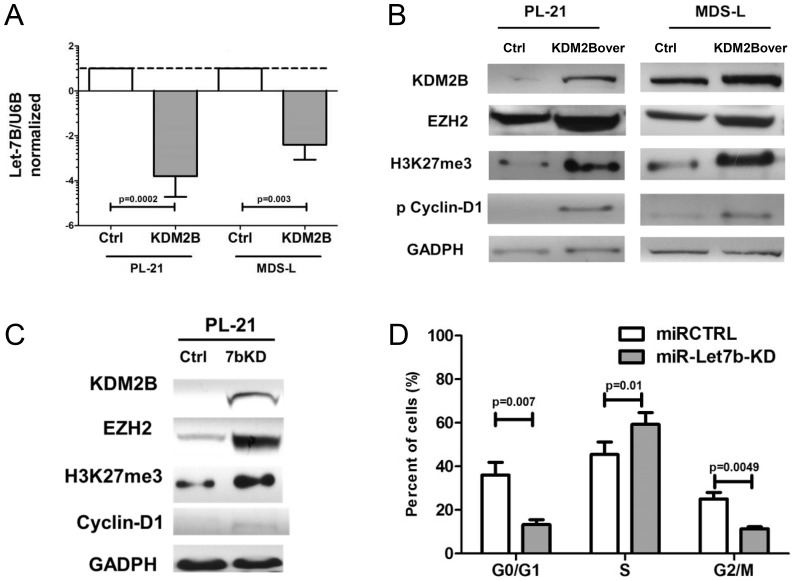
Effects of Let7b knockdown and KDM2B overexpression in myeloid cell lines.Overexpression of KDM2B in PL-21 and MDS-L cells resulted in decreased expression of let-7b (A) compared to controls (Ctrl; p = 0.0002 and 0.005, respectively, U6B served as loading control, mean ± SEM, Log 2 changes normalized for the expression in MDS-L cells) and increased EZH2, H3K27me3 and pCyclin-D1 proteins. (B) (GADPH served as control). The blots show one of 3 similar experiments. C) Knockdown of let-7b in PL-21 cells resulted in increased expression of KDM2B, EZH2, H3K27me3 and, to a lesser extent, cyclin-D1. The blots show one of 3 similar experiments. D) Knockdown of let-7b in PL-21 cells resulted in increased BrdU uptake/proliferation (increase of cells in S phase; p = 0.01 and a decrease of cells in G1 and G2; p = 0.007 and p = 0.005, respectively; mean±SEM of 3 experiments; Student's t-test for comparison of continuous variables).